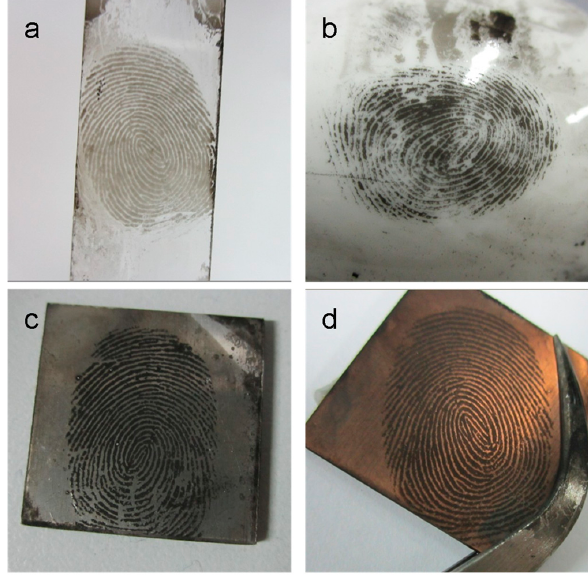
Figure 3. Cont. Figure 3.